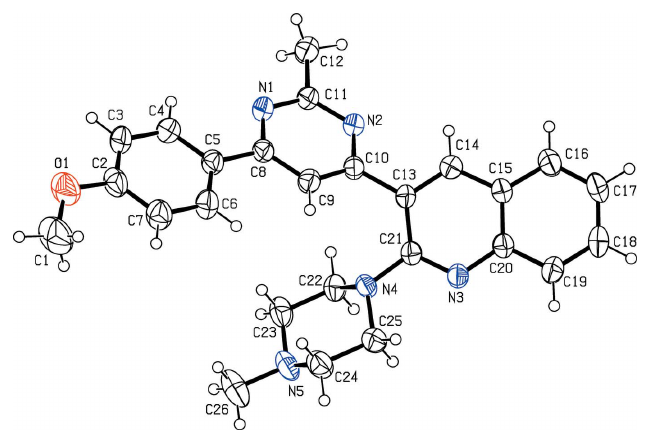
Figure 1 The molecular structure of the title compound. Displacement ellipsoids are drawn at the 40% probability level. H atoms are shown as small spheres of arbitrary